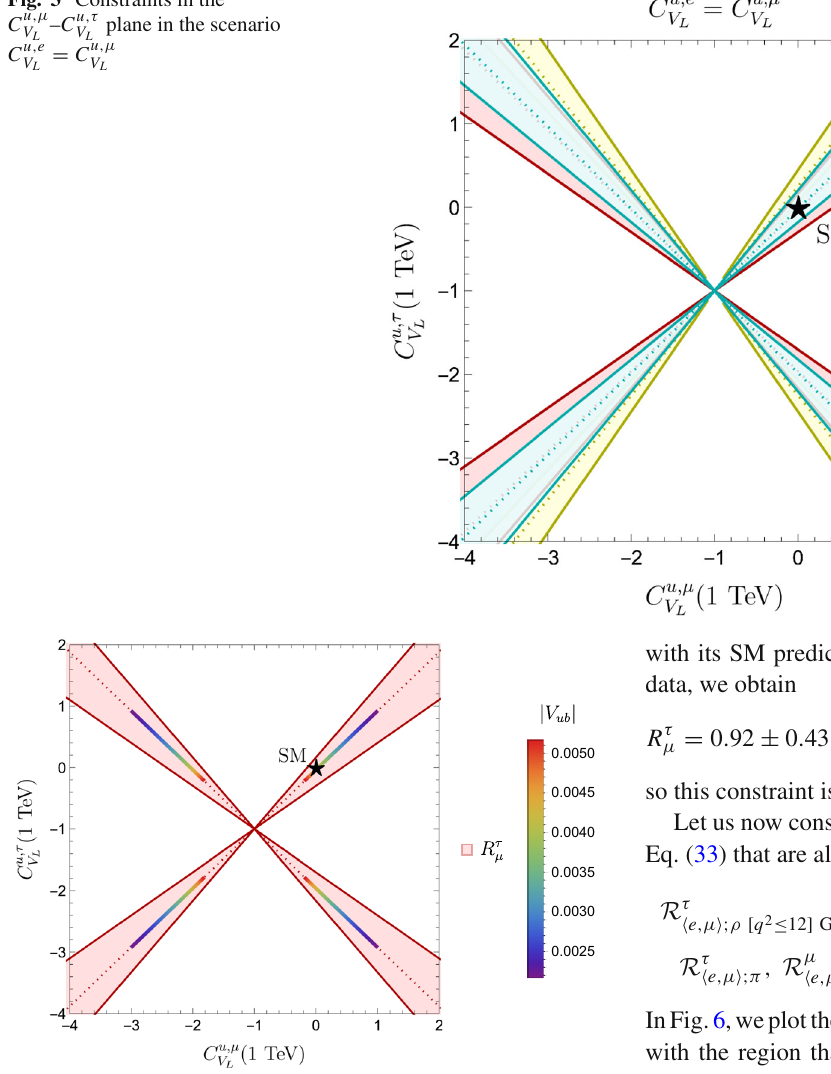
,μ – C u ,τ plane, withthevalue V L V L